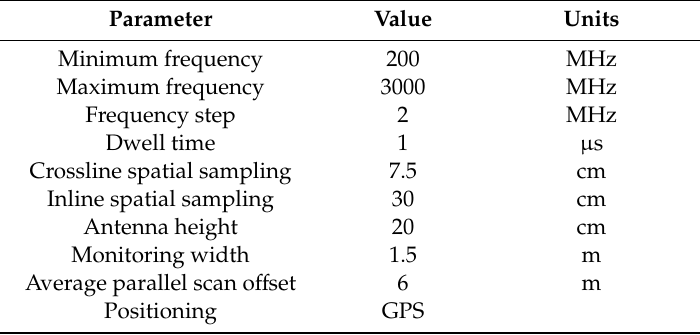
Table 1. Summary of equipment acquisition